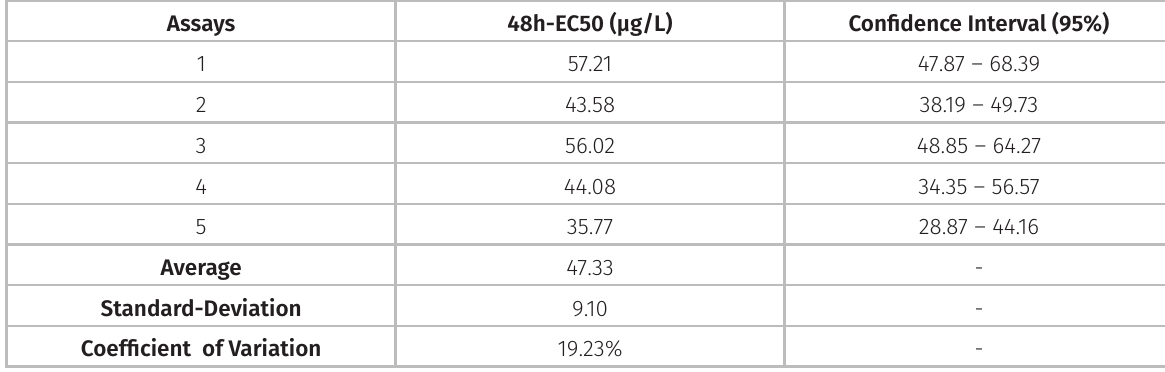
Table II. 48h-EC50 values for D. similis obtained in the tests with the fungicide Aproach Prima®. Assays